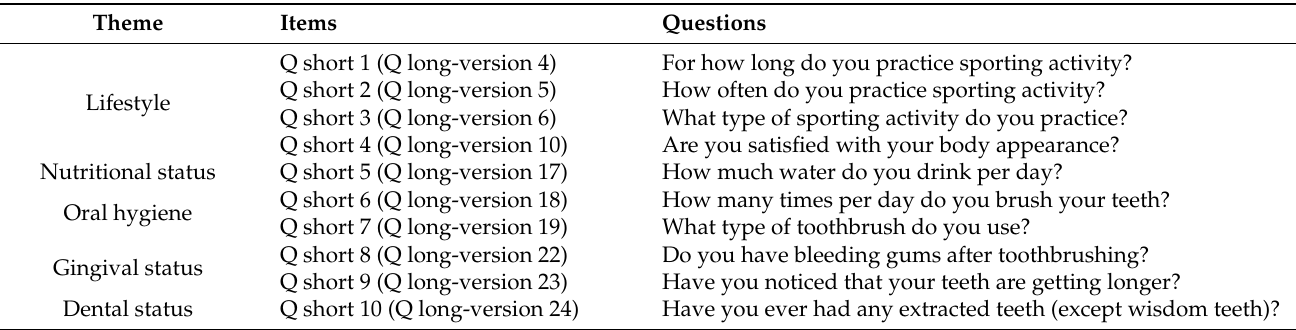
Table 4. Proposal for a short version of the self-report questionnaire based on the 10 most reliable items compared to the face-to-face